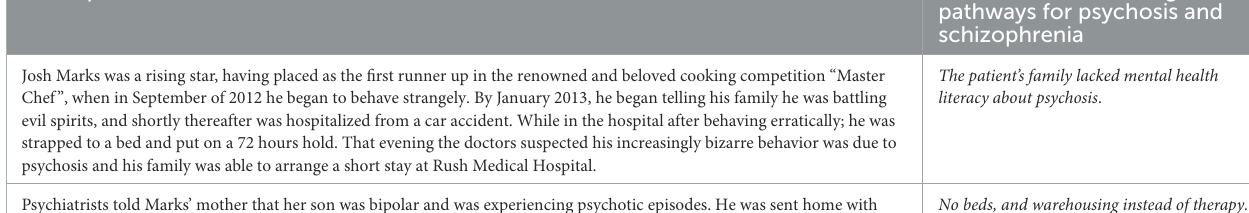
pathways for psychosis and